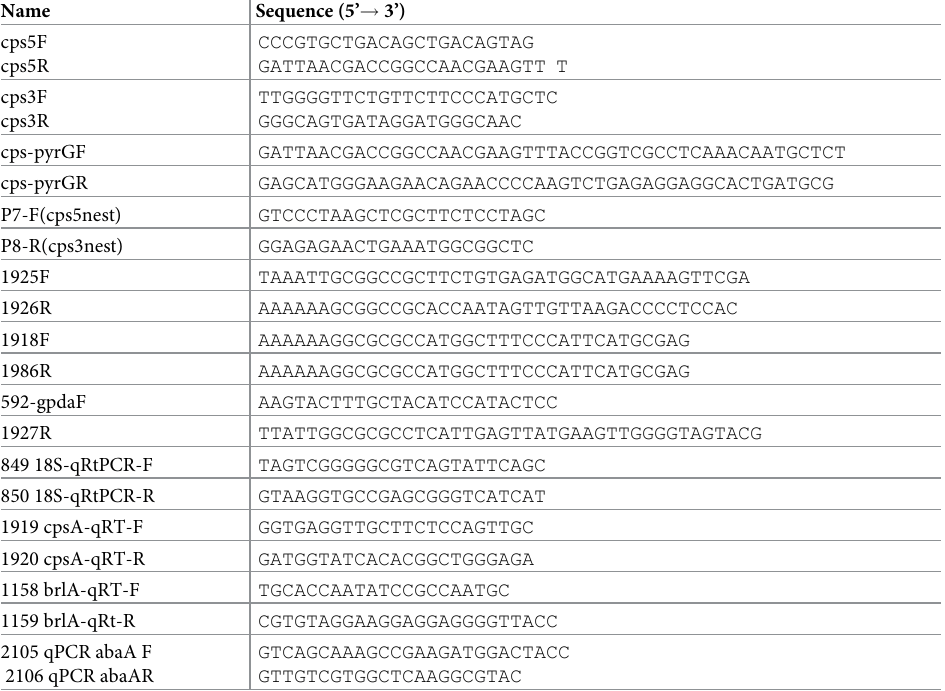
Table 2. Primers used in this